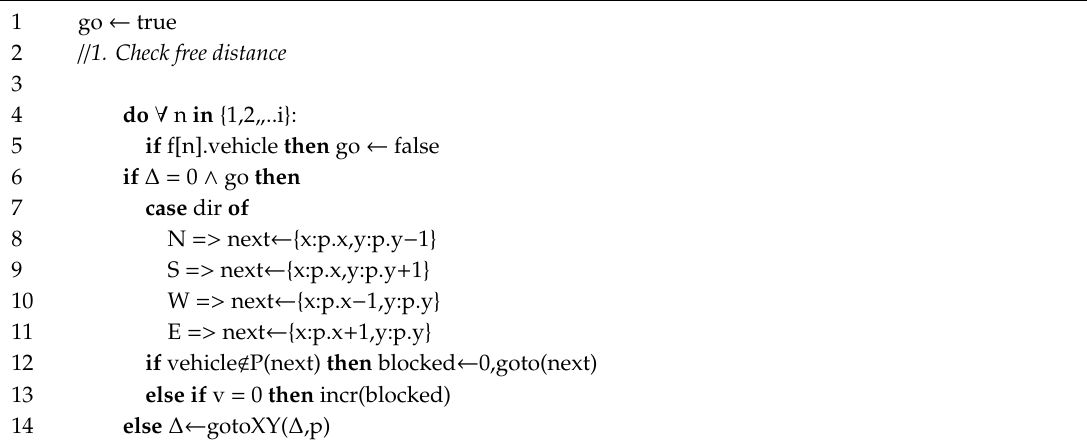
Algorithm 5. Simplified move activity of the vehicle agent. The gotoXY function moves the vehicle one step to a new free place minimizing min ∆ →